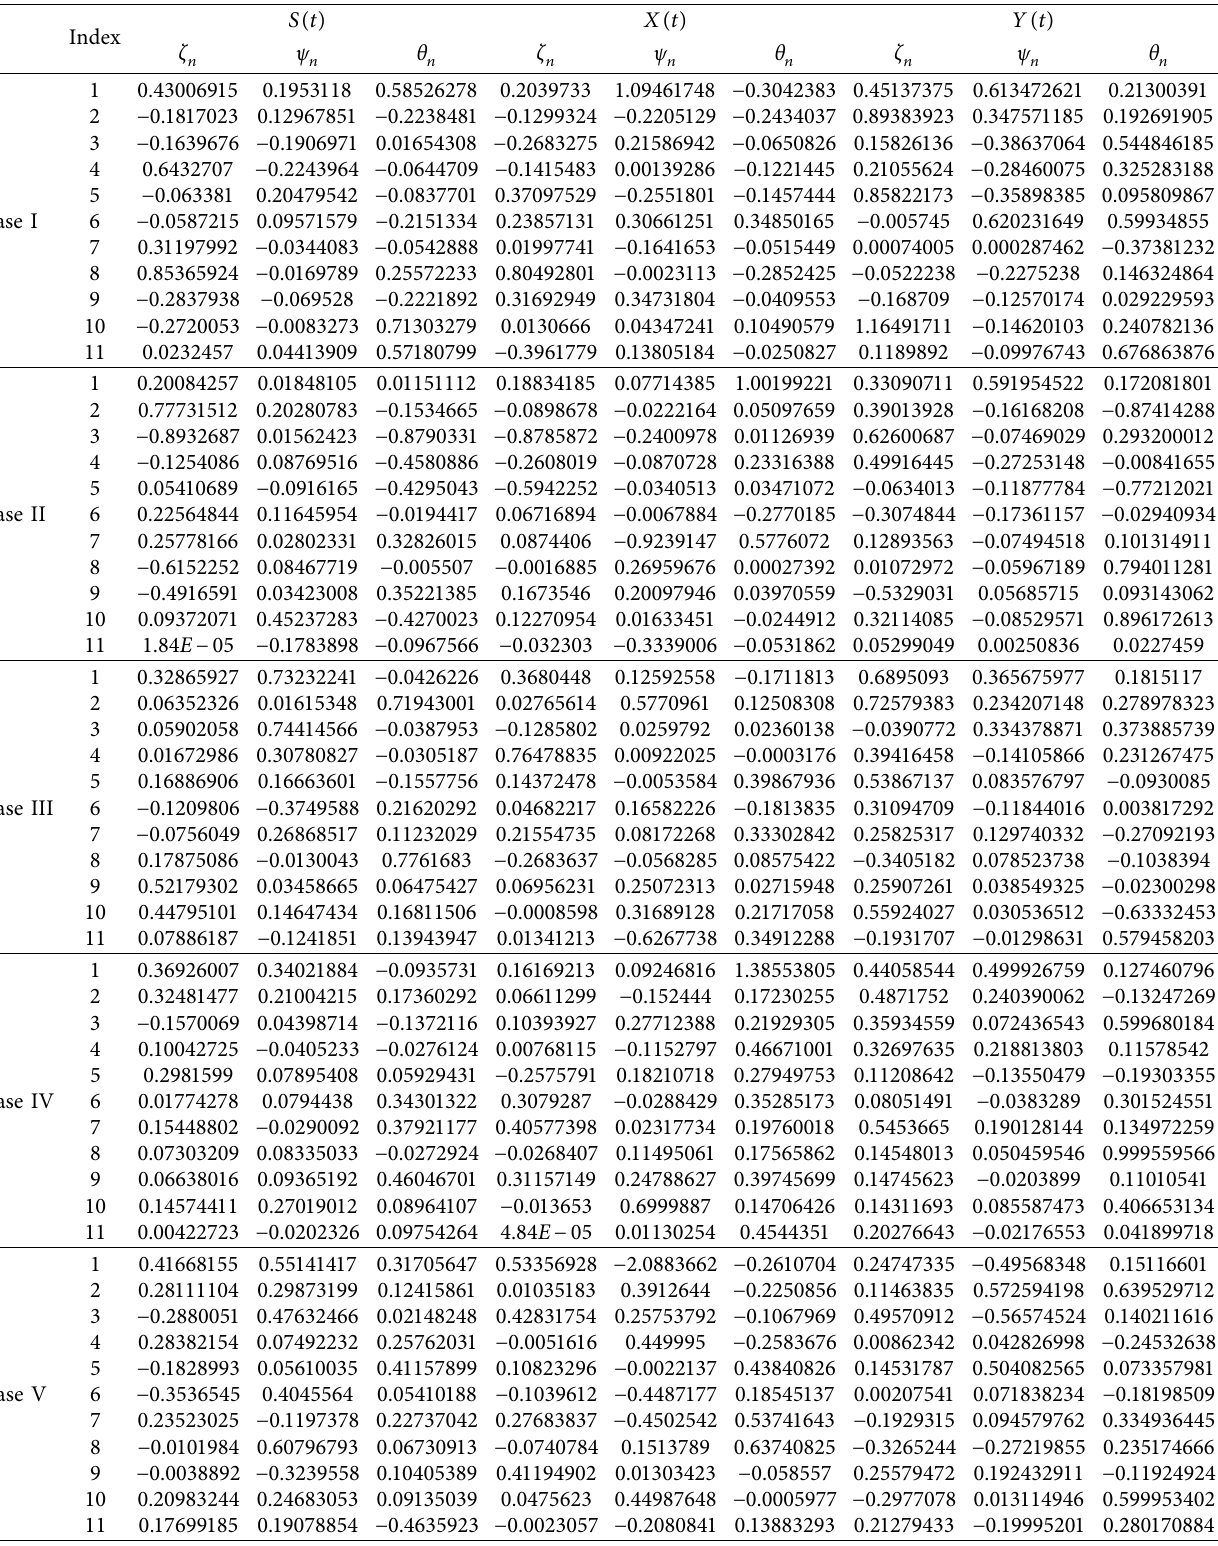
Table 20: Unknown parameters obtained by the LeNN-WOA-NM algorithm for the prey-predator model under the influence of variations in β 1